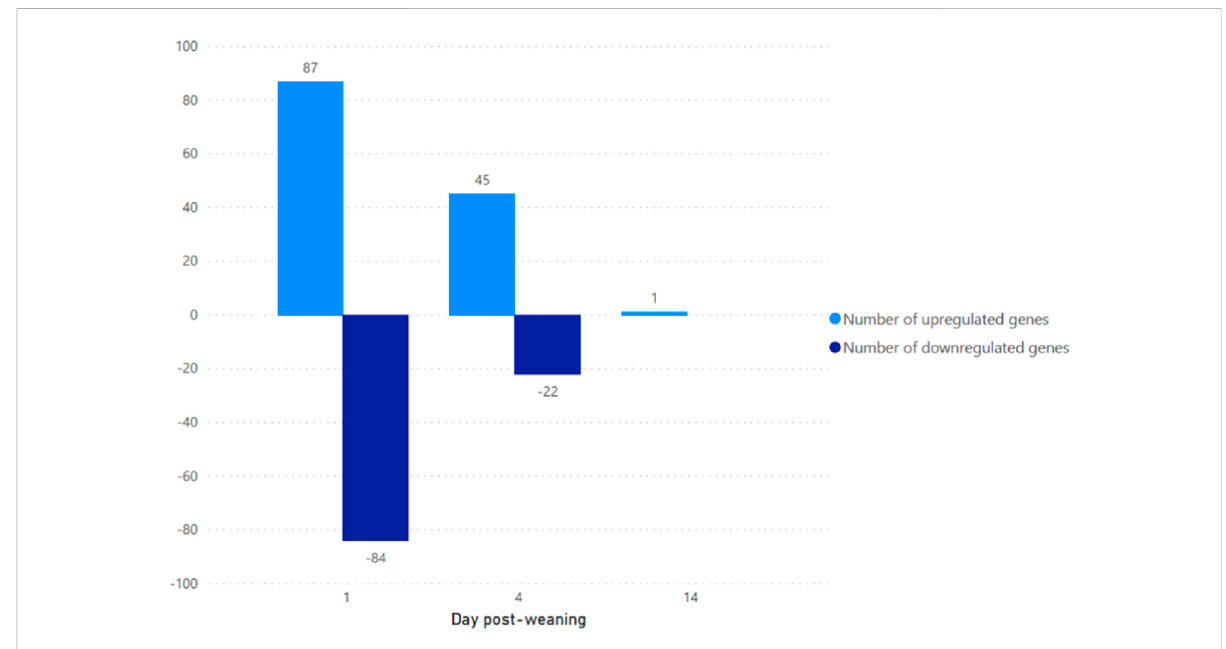
FIGURE 2 Number of up and downregulated transcripts between weaned and unweaned pigs at 1, 4, and 14 days post weaning (Qval ≤ 0.1 & FC ≥ 2).